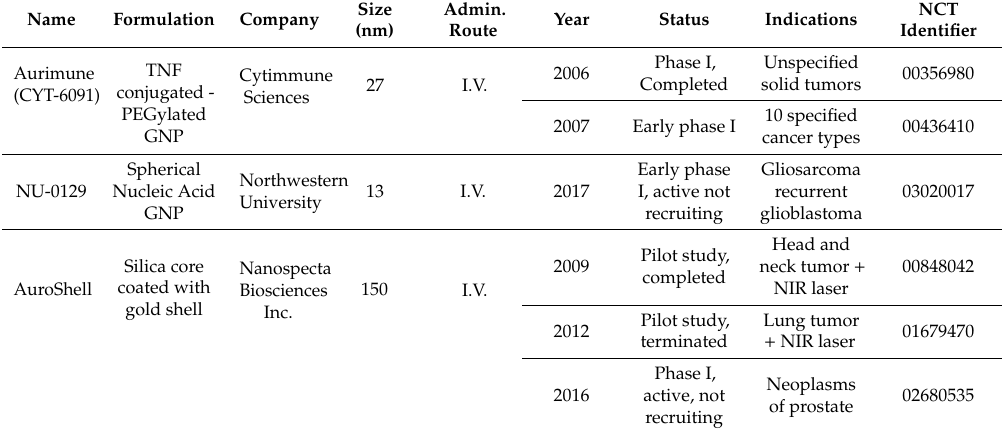
Table 3. List of clinical trials involving GNPs in oncology. NCT identifier is the clinical trial number referenced on the website